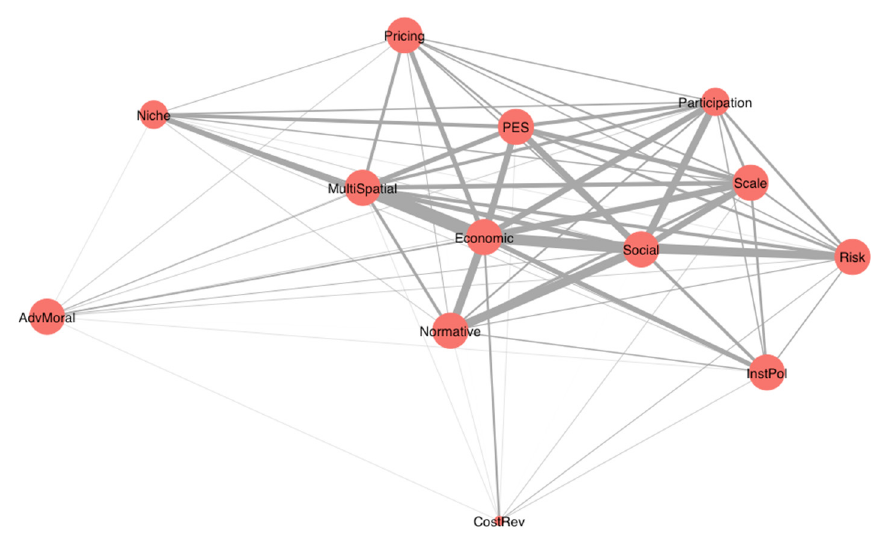
Figure 3. Intersections between the most prominent codes belonging to each theme. Nodes are scaled by degree, edges weighted by the number of intersections between each pair. Since only the most frequently-occurring codes from each theme were selected to avoid crowding the figure, connectivity is high, but prominent pairs are apparent in the central cluster. AdvMoral: adverse selection and moral hazard (see Section 3.3.3). Niche: Auction niche (Section 3.5.2). Pricing: see Sec-